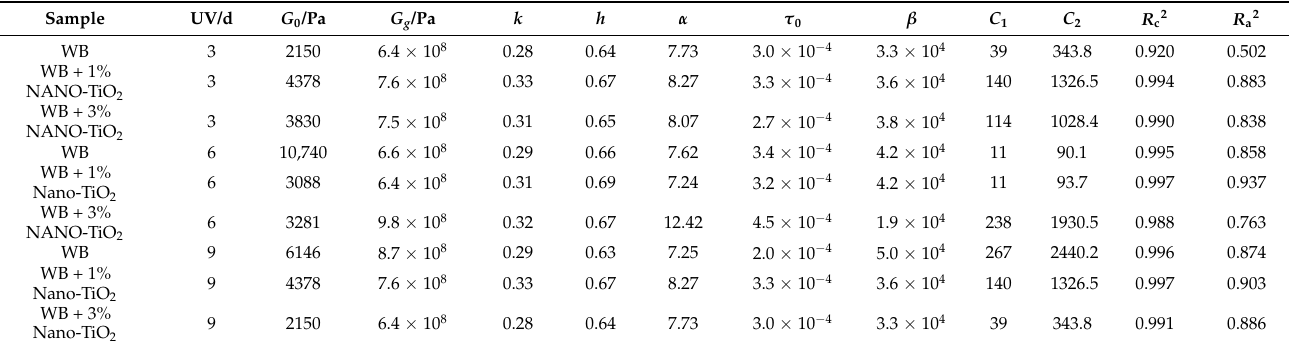
Table 1. Model coefficients for various UV-aged